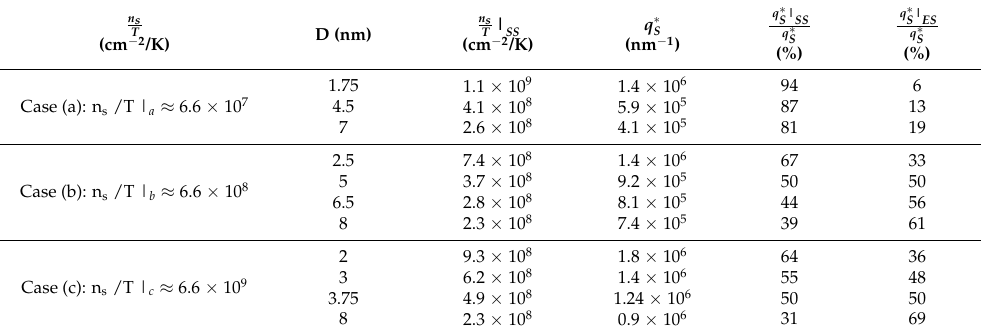
(cid:12) (cid:12) , q ∗ and q ∗ parameter values, (cid:12) (cid:12) S S S SS ES